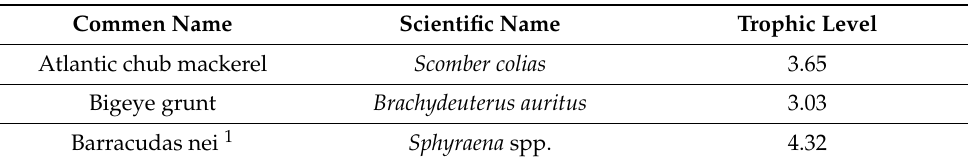
Table 1. Trophic level values for the top 20 species (according to the catch data in the year 2019) used to compute mean trophic level.